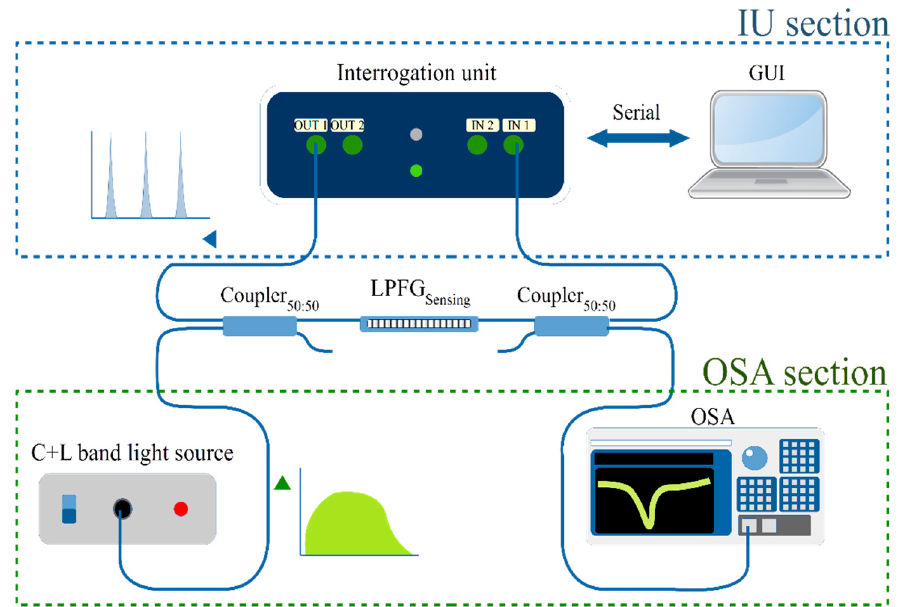
Figure 6. Setup for the measurements, with the LPFG as the sensing component. The graphical user interface (GUI) is used to control the interrogation unit and data acquisition. The blue section represents the IU scheme, the green section shows the BBLS/OSA utilized for system validation. Only one of the sections are making measurements at any one time.